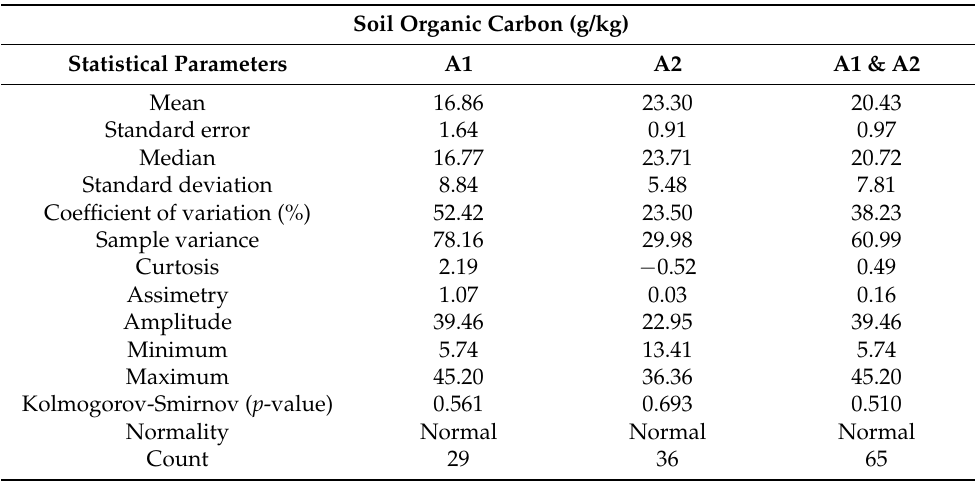
Table 2. Descriptive statistics for the SOC content of the data, separated by area of collection (A1; A2) and unified into one set (A1 &